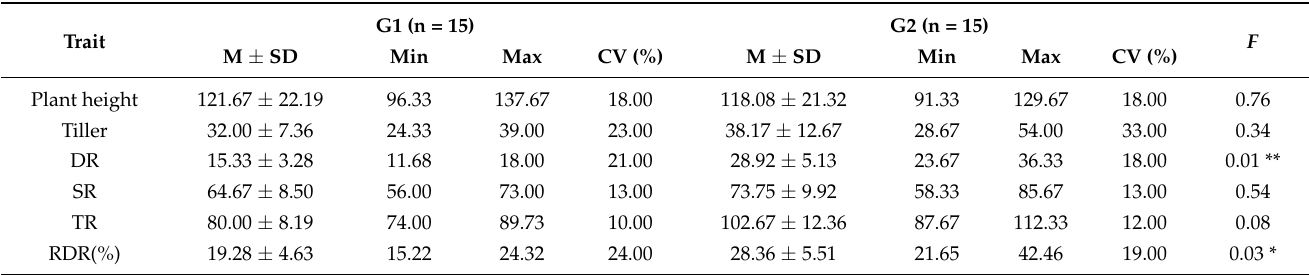
Table 4. The performance of root and other agronomic traits in the two subpopulations of nuclear genome resequencing in DXWR. n = 15 means the sample size of each subpopulation containing 15 strains, and six plants were investigated for each strain. DR: number of deep roots, SR: number of shallow roots, TR = (DR + SR): number of total roots, RDR = (DR/TR): the ratio of deep roots. “**” indicate significance at levels of p < 0.01 by independent t -test. “*” indicate significance at levels of p < 0.05 by independent t